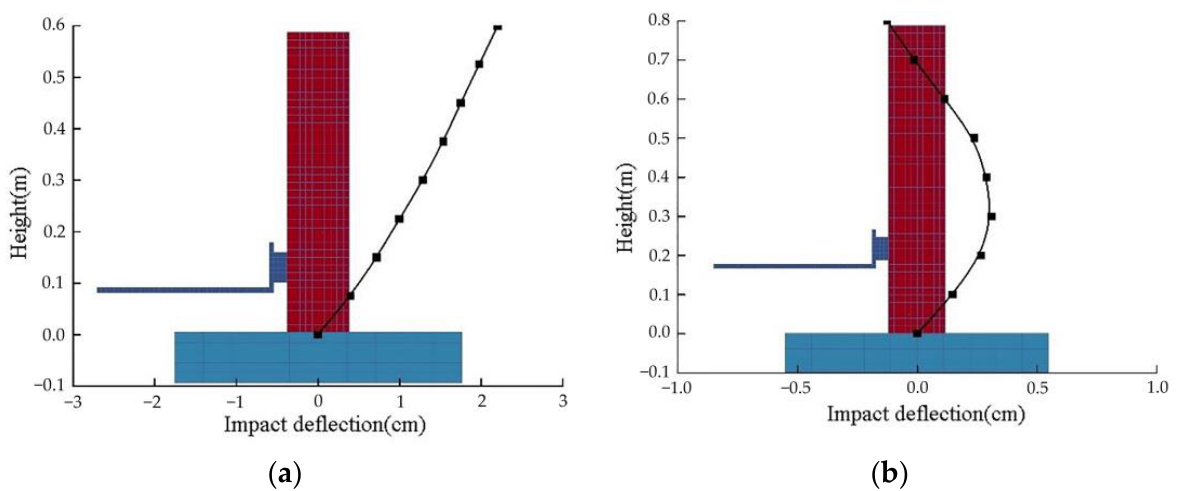
Figure 16. Comparison of RCC failure mode: ( a ) impact deflection curve of C_1 and ( b ) impact deflection curve of C_2.